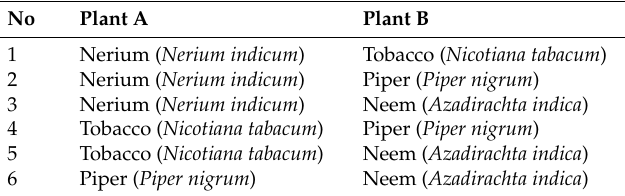
Table 2. Binary combination of plant extracts.